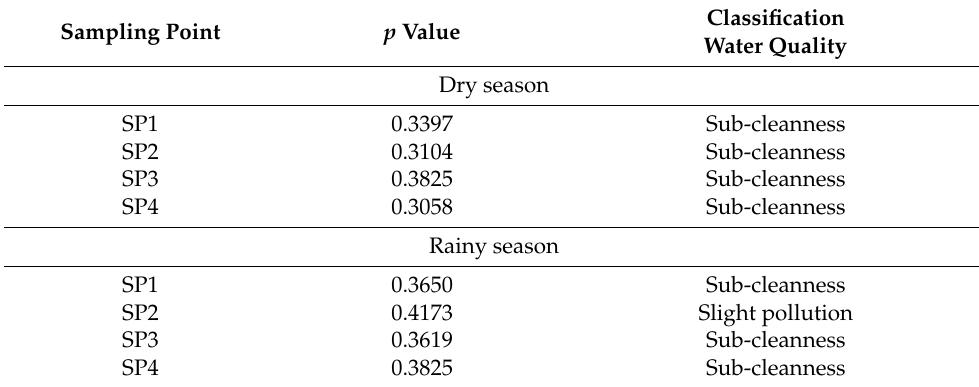
Table 3. Comprehensive pollution index ( p ) values obtained in ALM reservoir. Sampling